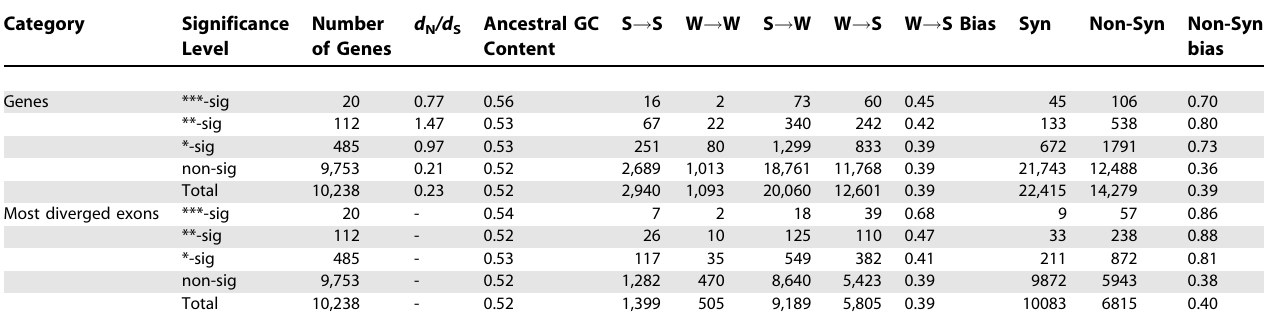
Table 5. Patterns of Nucleotide Substitution in Genes with Human-Accelerated d N /d S